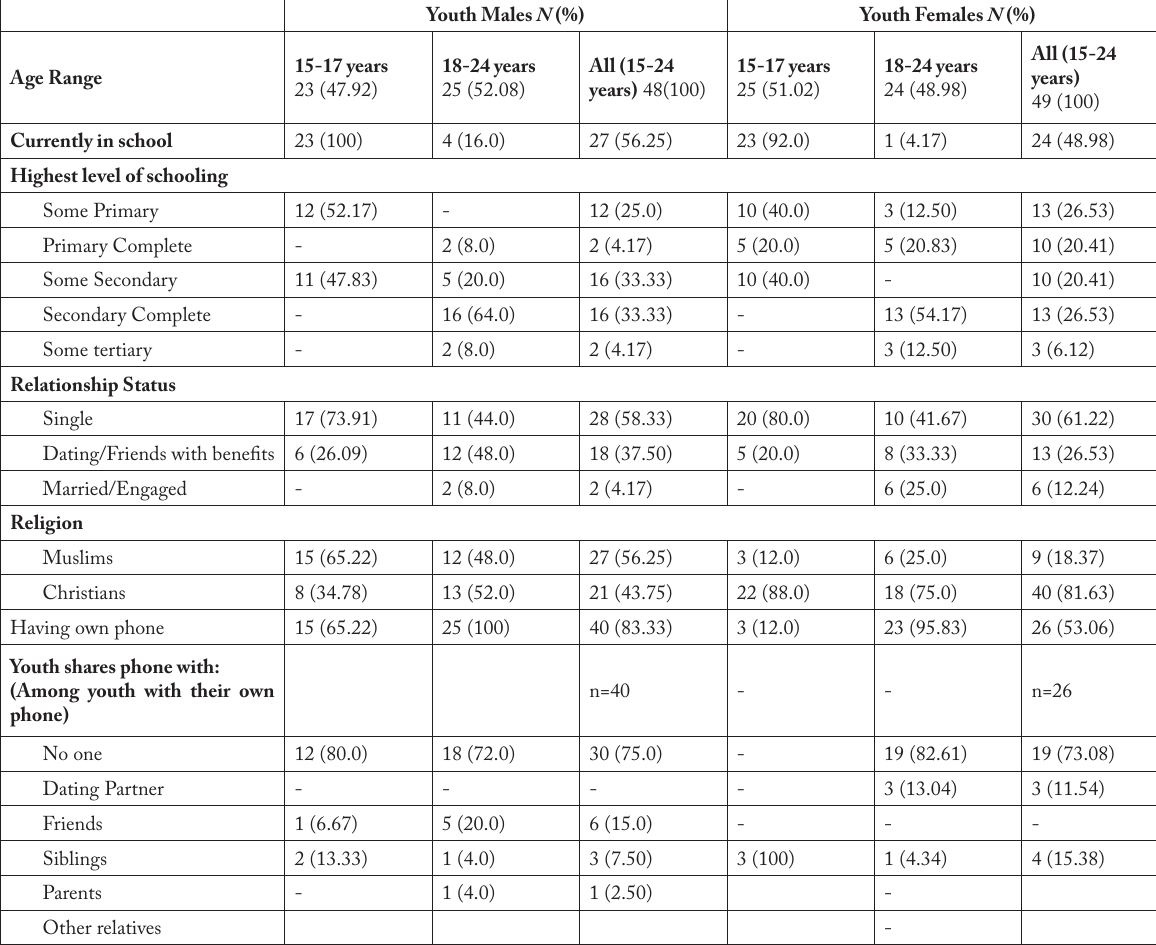
Table 1. Sociodemographic and other characteristics of young people participating in the study, by sex ( N = 97).